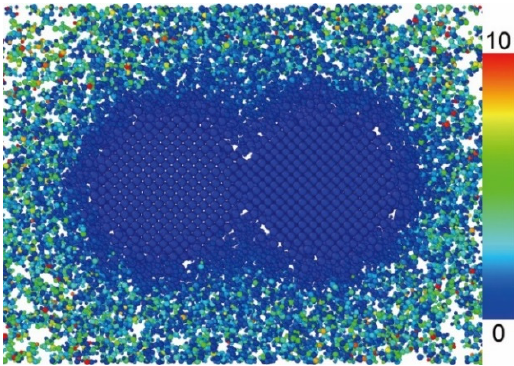
Figure 17. Kinetic energy distribution of sliced double sphere model (unit: kcal/mole).